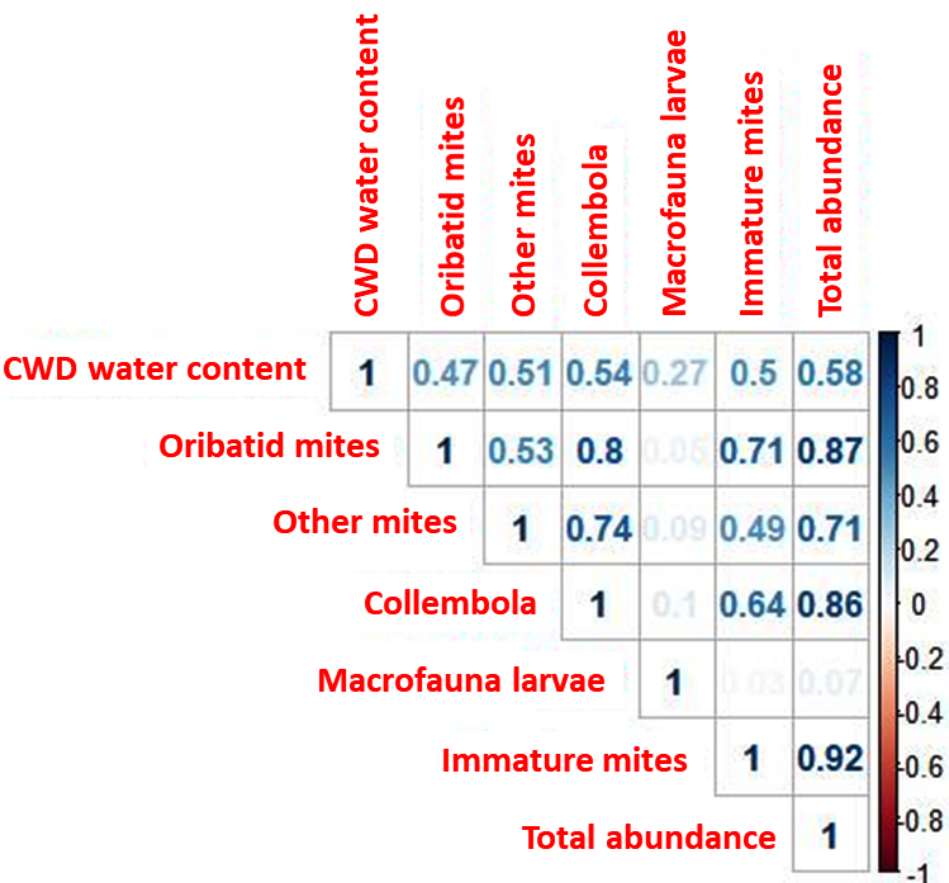
Figure 2. Correlations matrix considering the variables that represented a higher variance (%) in forest thinning, canopy type and decay class of coarse woody debris (CWD).